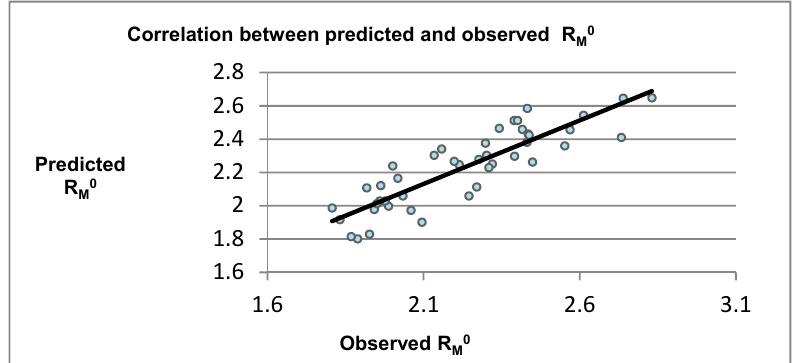
Figure 1. Plot showing correlation between observed and predicted R M0 , using multiple linear regression (MLR).